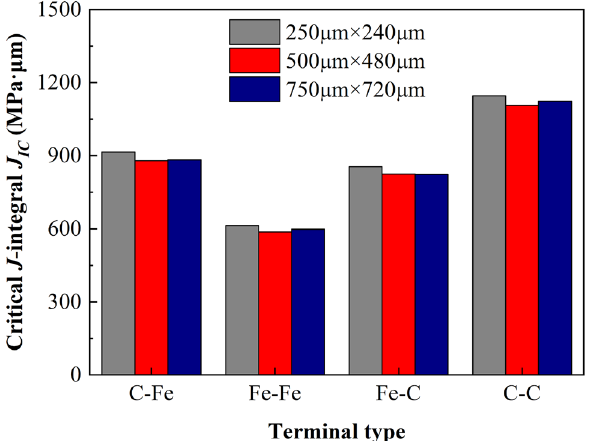
Figure 25. Critical J -integral distribution of each terminal interface under different size models.